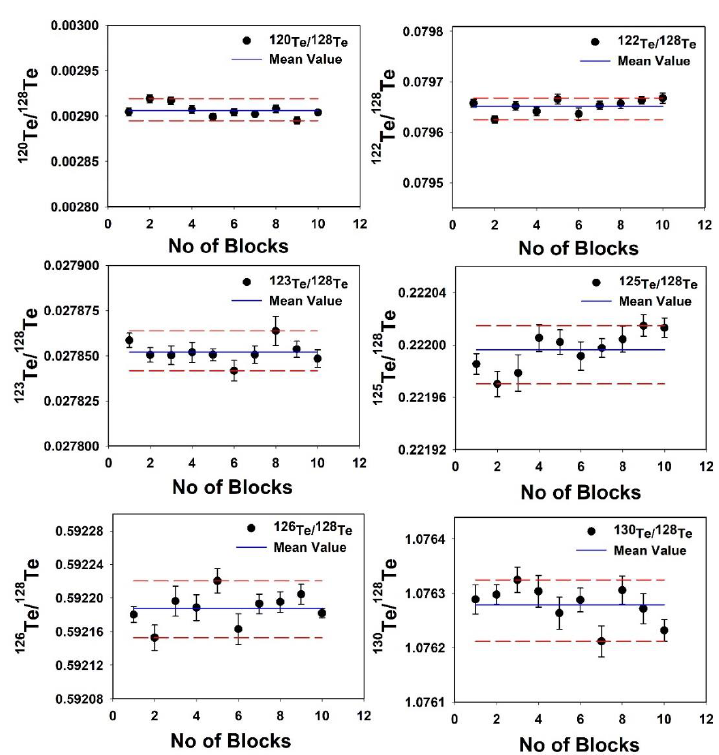
Figure 1. Stability of the isotope ratio measured using multi-collector inductively coupled plasma mass spectrometry (MC–ICP–MS). The dotted red line represents two standard errors (2SE) of a single measurement. Each block represents the mean of 20 individual ratios.